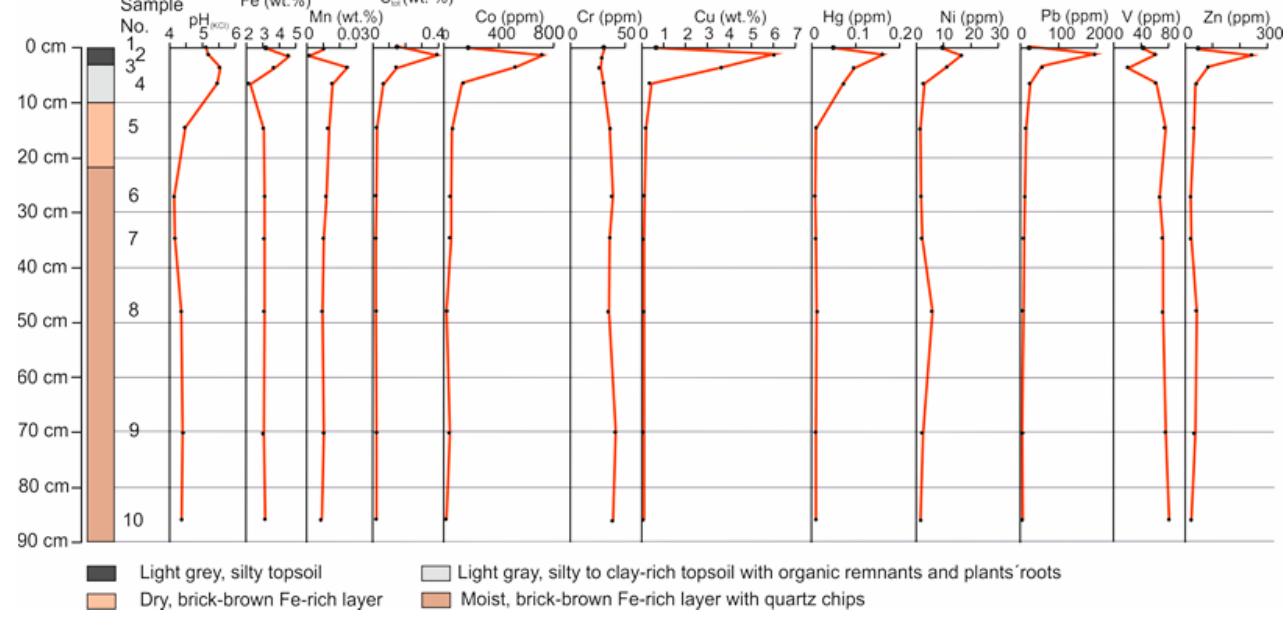
Figure 6. Distribution of pH, Fe, Mn, S tot , and trace elements in a heavily polluted Ferrasol profile, located 1 km north-west of the Nkana Smelter (SW outskirts of the Kitwe Township), Zambia. Modified after K ř íbek and Nyambe [93] .